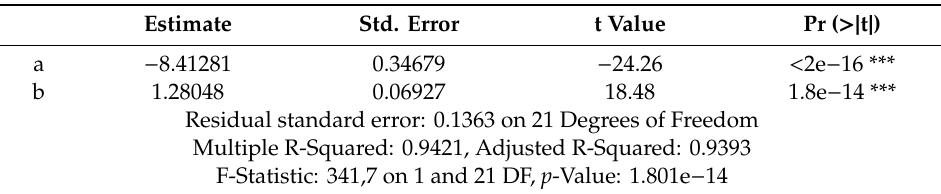
Table 9. Statistical parameters for the power regression model.